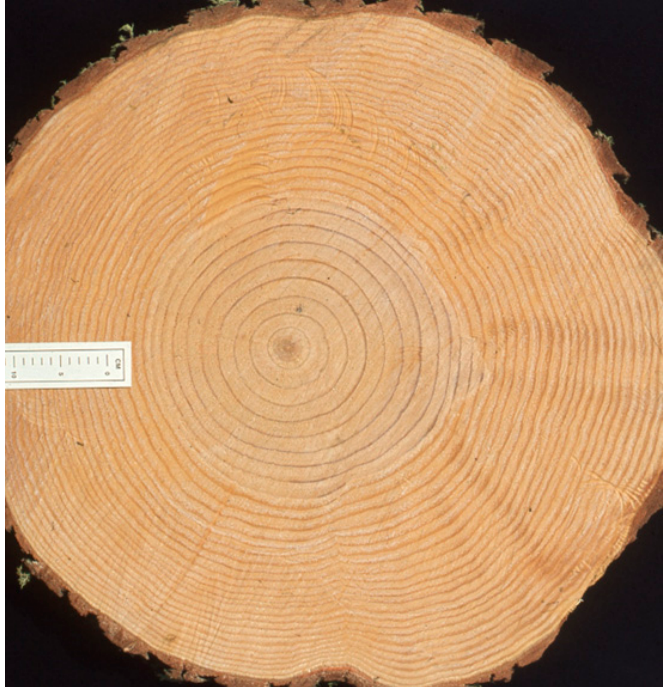
Figure 8. Stem disc of P. radiata , showing) increasing proportion of latewood in rings from pith to bark, and wide zone of sapwood, which confers high hydraulic capacitance. (Scion Image Library).